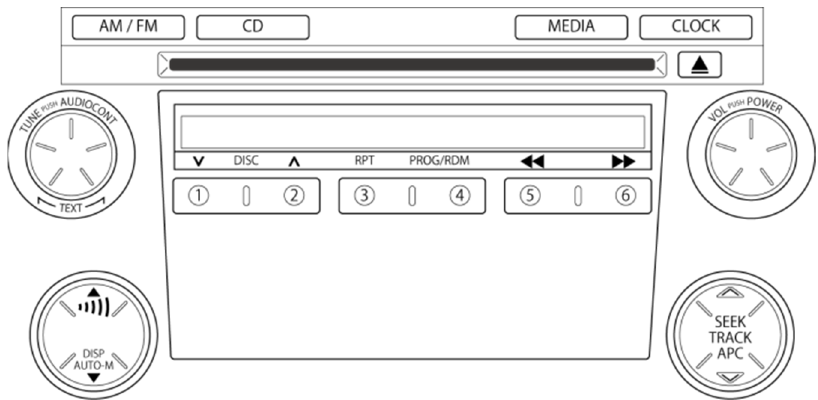
Figure 1. The user interface of the evaluated in ‐ vehicle audio